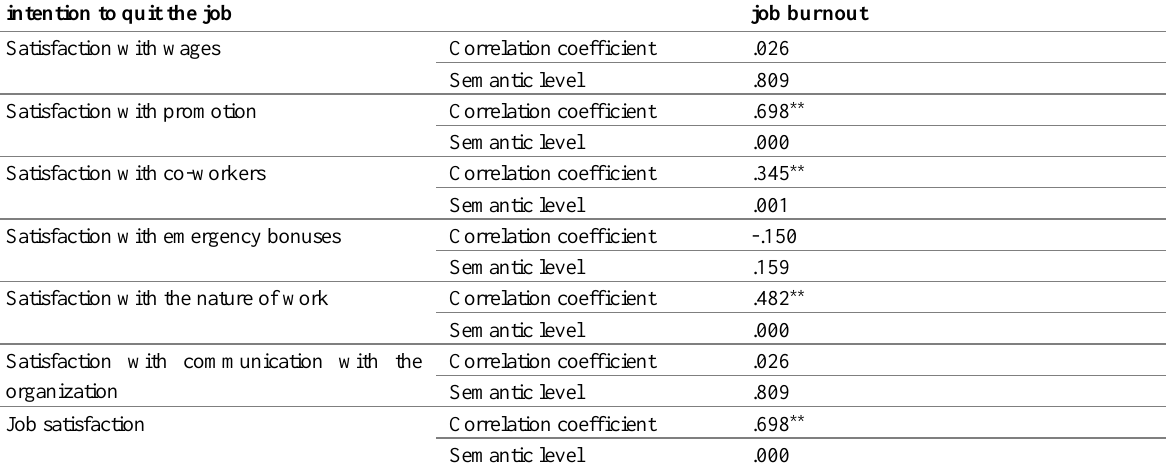
Table 3: Pearson correlation coefficient between job burnout and intention to leave the job and its sub-dimensions intention to quit the job job burnout Satisfaction with